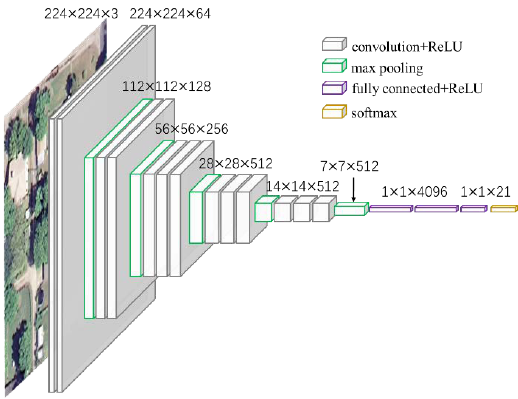
Figure 1. The example architecture of remote sensing scene classification using VGG-VD16. It is composed of 13 convolutional layers and 3 fully-connected layers.